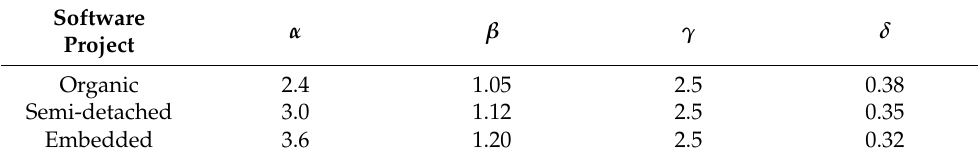
Table 1. Coefficients and exponent values as in [25].